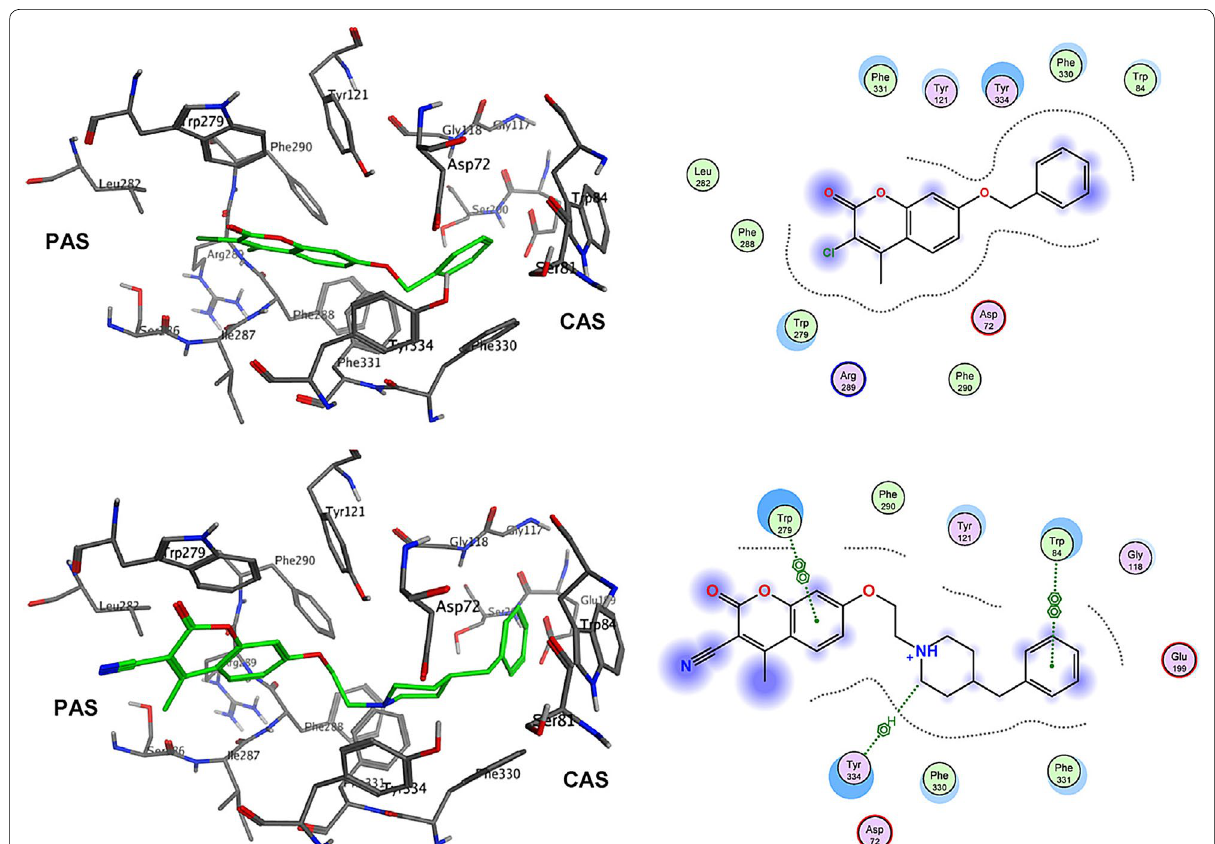
Fig. 89 The eelAChE active site cavity (left) and interaction maps (right) displaying the binding and interactions of compounds C96b (top) and C96c (bottom)